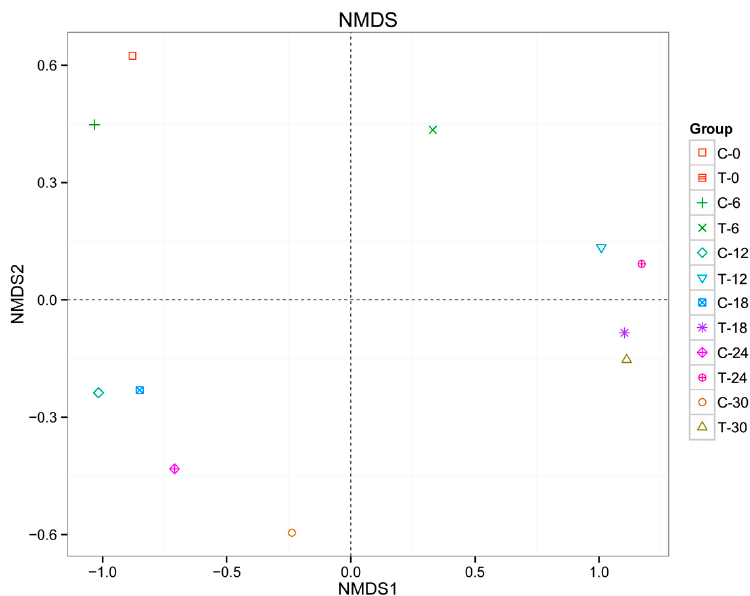
Figure 3. NMDS plots derived from pairwise unweighted UniFrac distances between bacterial communities in the controls (C) and in the treatments (T). The numbers behind the C/T represent the processing time.